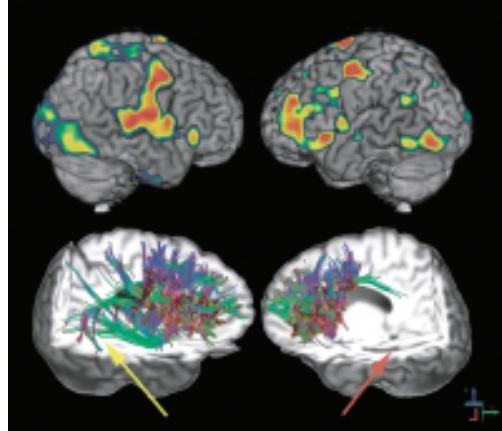
Fig. 2. The fMRI (top) showed increased Broca’s and, to a lesser extent, Wernicke’s area activity during picture naming attempts. The tractography (bottom) showed where tracts fromthe right homologue of Broca’s area extended via the arcuate fasciculus to the right su- perior temporal lobe (yellow arrow); this was not the case for the injured left hemisphere (red